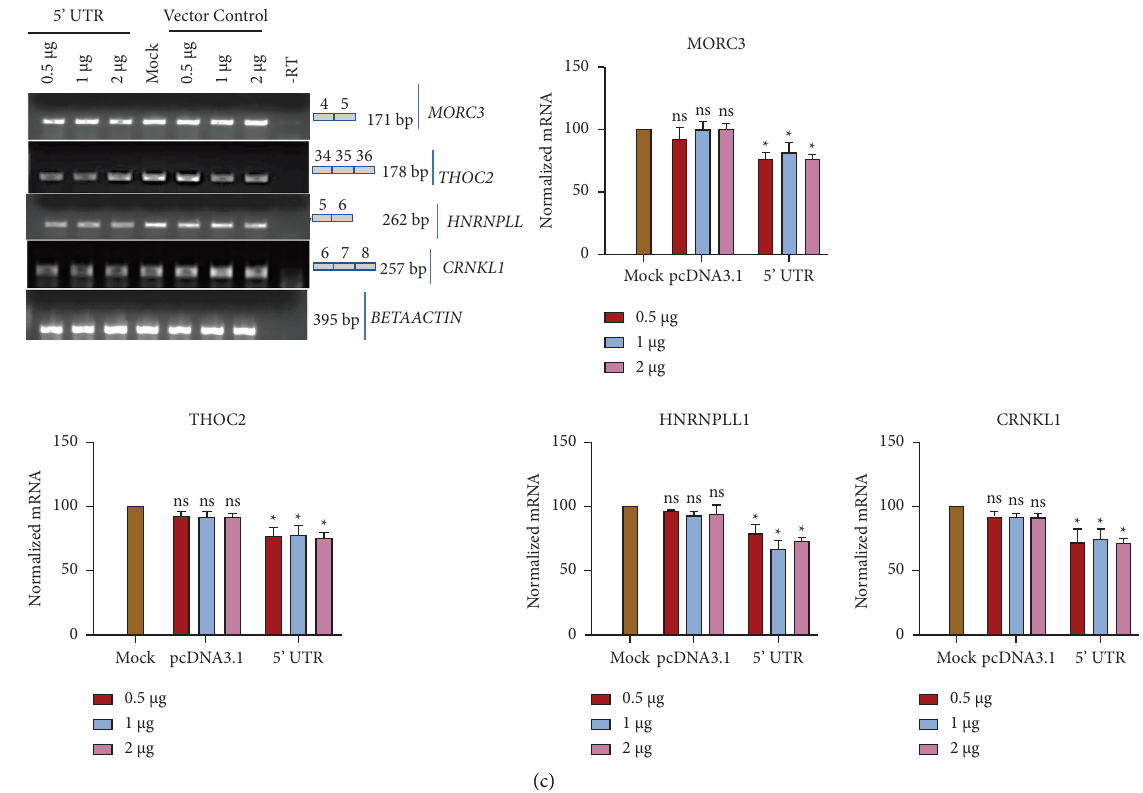
Figure 3: SARS-CoV-2 5 ′ UTR and 3 ′ UTR overexpression infuences host pre-mRNA splicing: (a) schematic representation of primers used for splicing assays. Boxes indicate the exon, while lines indicate the intron. Arrow suggests the position of primers used in the study. (b) 293Tcells were transfected with increasing concentrations (0.5, 1, and 2 µ g) of either empty vector (pcDNA3.1) or recombinant pcDNA3.1 encoding the SARS-CoV-2 3 ′ UTR. Total RNA was isolated 24hours post-transfection. Alternate splicing of MORC3, THOC2, HNRNPLL, and CRNKL1 was probed using RT-PCR. Actin was used as a loading control. (c) 293Tcells were transfected with increasing concentrations (0.5, 1, and 2 µ g) of either empty vector (pcDNA3.1) or recombinant pcDNA3.1 encoding the SARS-CoV-2 5 ′ UTRs. Total RNA was isolated 24hours post-transfection. Alternate splicing of MORC3, THOC2, HNRNPLL, and CRNKL1 was probed using RT-PCR. Actin was used as a loading control. Statistical signifcance was determined using two-way ANOVA: P < 0 . 05; P < 0 . 01; P < 0 .